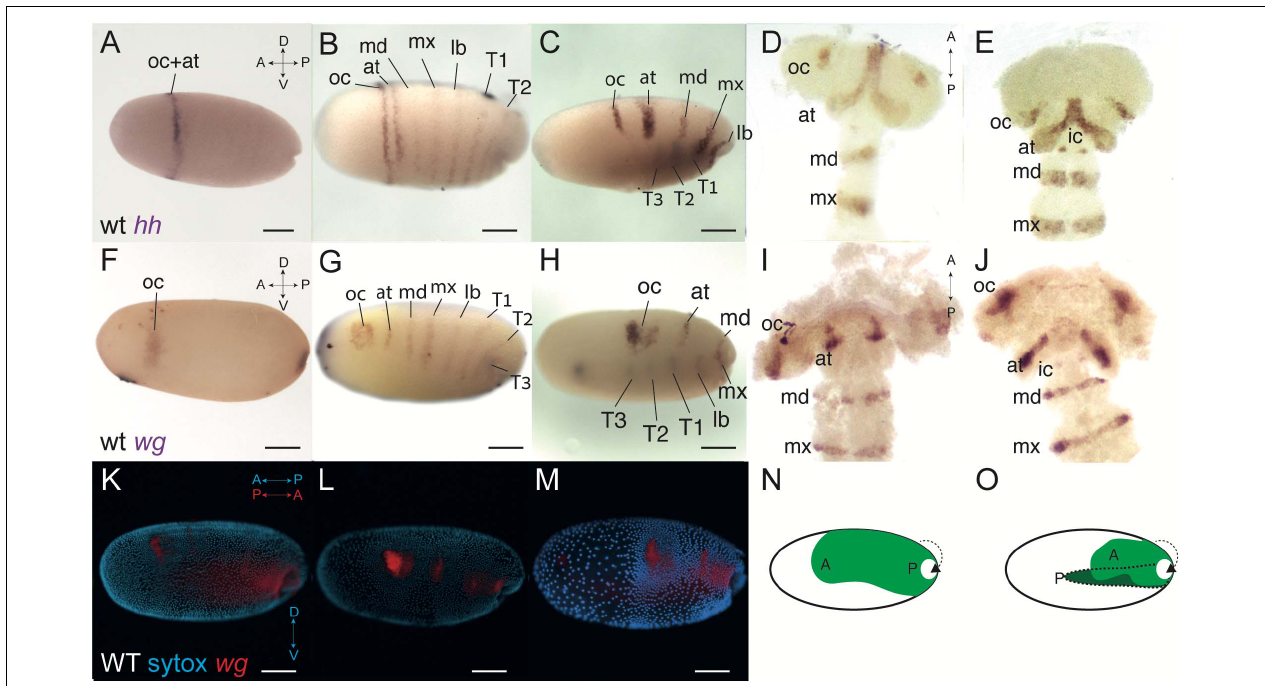
FIGURE 1 | Wild-type expression of hedgehog ( hh ) and wingless ( wg ) in Oncopeltus, before and after blastoderm invagination. (A) Expression of hh at 32 h after egg laying (hAEL), late blastoderm stage, is as a ring in the anterior third of the embryo. (B) At around 36 hAEL, the hh anterior expression ring splits into two stripes corresponding to the presumed ocular and antennal segments. Six additional stripes of expression appear, corresponding to the presumed gnathal and thoracic segments. (C) Embryo at mid-invagination, ∼ 42 hAEL. The two anterior stripes are fully separated. Thoracic segments have already invaginated and expression in them can be seen through the yolk. (D,E) Germband embryos, ∼ 48–52 hAEL. In the later germband embryo, ∼ 52 hAEL (E) , two dots of hh expression appear in the presumed intercalary segment, which are not seen in the earlier embryo (D) . (F) Expression of wg at ∼ 32 hAEL is located to an anterior stain and a posterior stain marking the future invagination site. (G) At ∼ 36 hAEL seven stripes of expression appear simultaneously, corresponding to the presumed antennal, gnathal, and thoracic segments. (H) Embryo at mid-invagination, ∼ 42 hAEL. This embryo is slightly older than the one in C as evidenced by the extent of invagination. (I,J) Germband embryos, ∼ 48–52 hAEL. In the later germband embryo, ∼ 52 hAEL (J) , two dots of wg expression appear in the presumed intercalary segment, which cannot be seen in the earlier embryo (I) . (K,M) The process of invagination from ∼ 36–42 hAEL. Nuclei stained by SYTOX in cyan and wild-type wg expression in red. When invagination begins (K) , the blastoderm is still mostly uniform. At mid-invagination (L) most blastoderm cells migrate dorsally, with the anterior cells, corresponding to the future head, condensing to give a head lobe. At late invagination (M) the head lobe is distinct. At this stage, the anterior-posterior axis of the egg is opposite to that of the invaginating embryo. (N,O) Illustration of the invagination process. “A” marks the embryonic anterior and “P” the posterior. The portions of the embryo that have invaginated to give the germband are shown in darker green. Panel (N) corresponds to the embryo in (L) and panel (O) corresponds to the embryo in (M) . at, antennal segment; ic, intercalary segment; lb, labial segment; oc, ocular segment; md, mandibular segment; mx, maxillary segment; T1–T3, first to third thoracic segments. Axis labels: A, anterior; P, posterior; D, dorsal; V, ventral. All scale bars are 200 µ